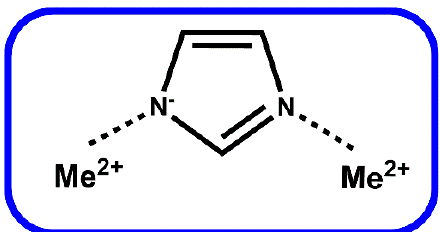
Figure 3. Bonding scheme of metal ions with imidazole ligands .